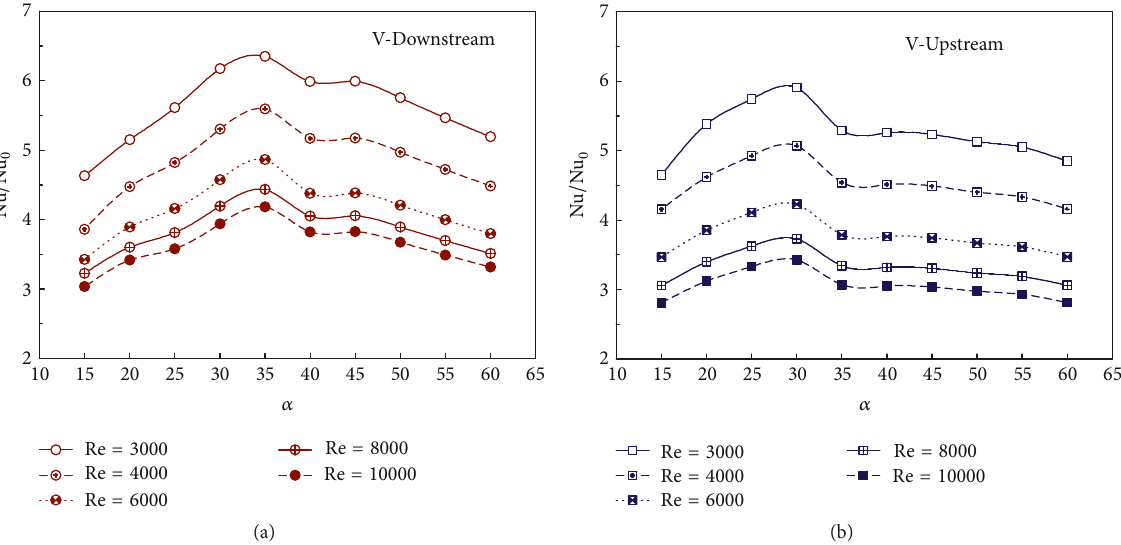
Figure 10: Nu/Nu 0 versus 𝛼 for the square channel inserted with V-wavy plate at various Reynolds numbers of (a) V-Downstream and (b)